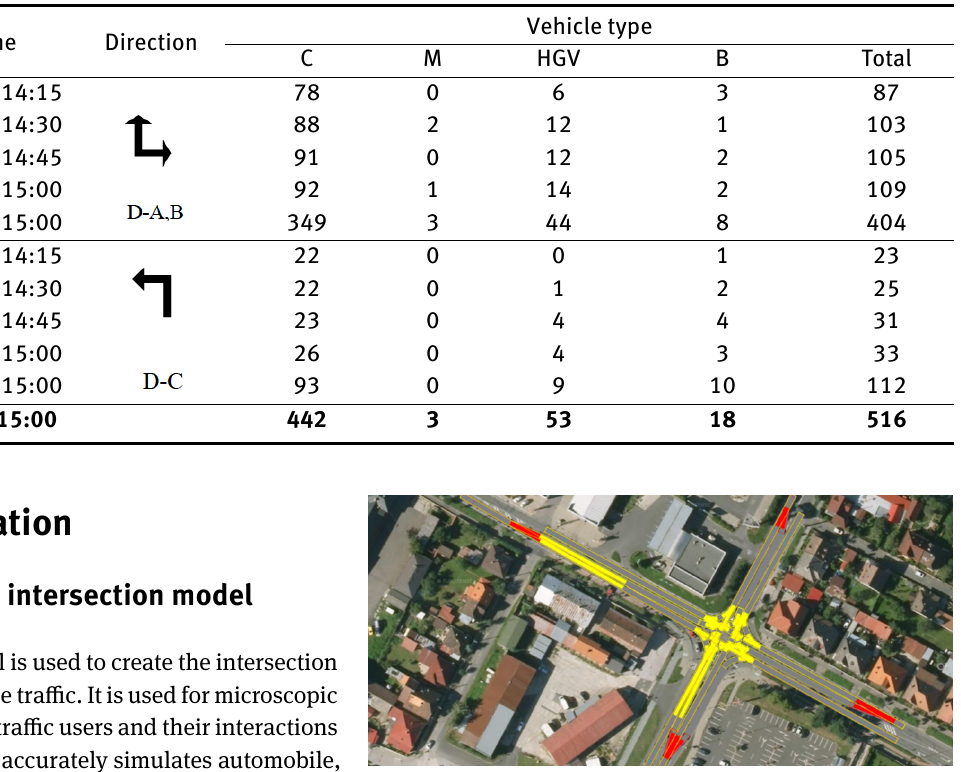
needs to be defined. In our case, the conflict areas of the in- tersection remain passive (coloured yellow, see Figure 4), because it is a traffic light- controlled